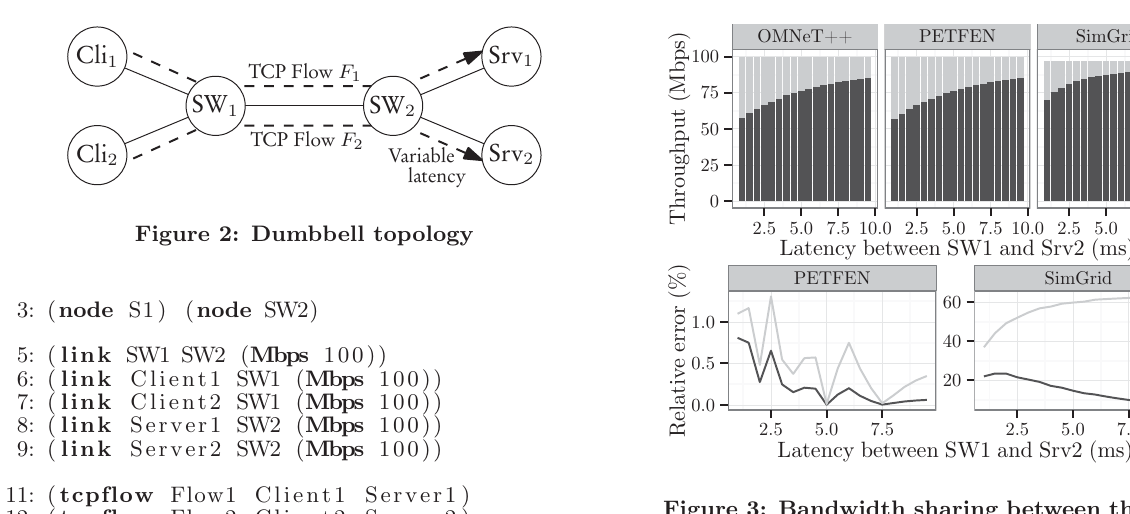
Figure 3: Bandwidth sharing between the two flows with different round-trip times and relative error with OMNeT++ as a